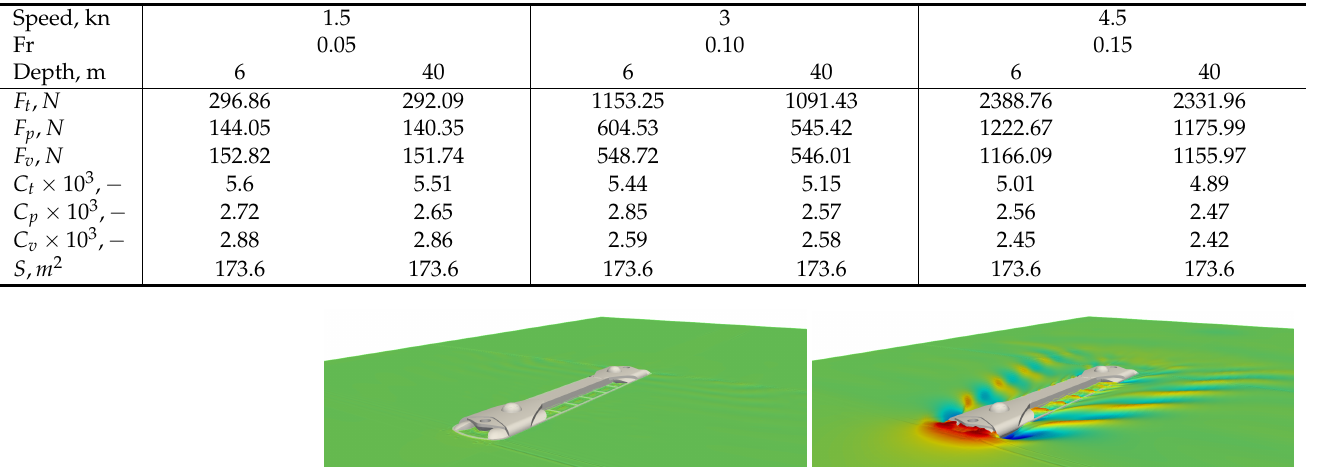
Table 5. Resistance results for the smooth cylindrical pressure hull, Geometry 1.